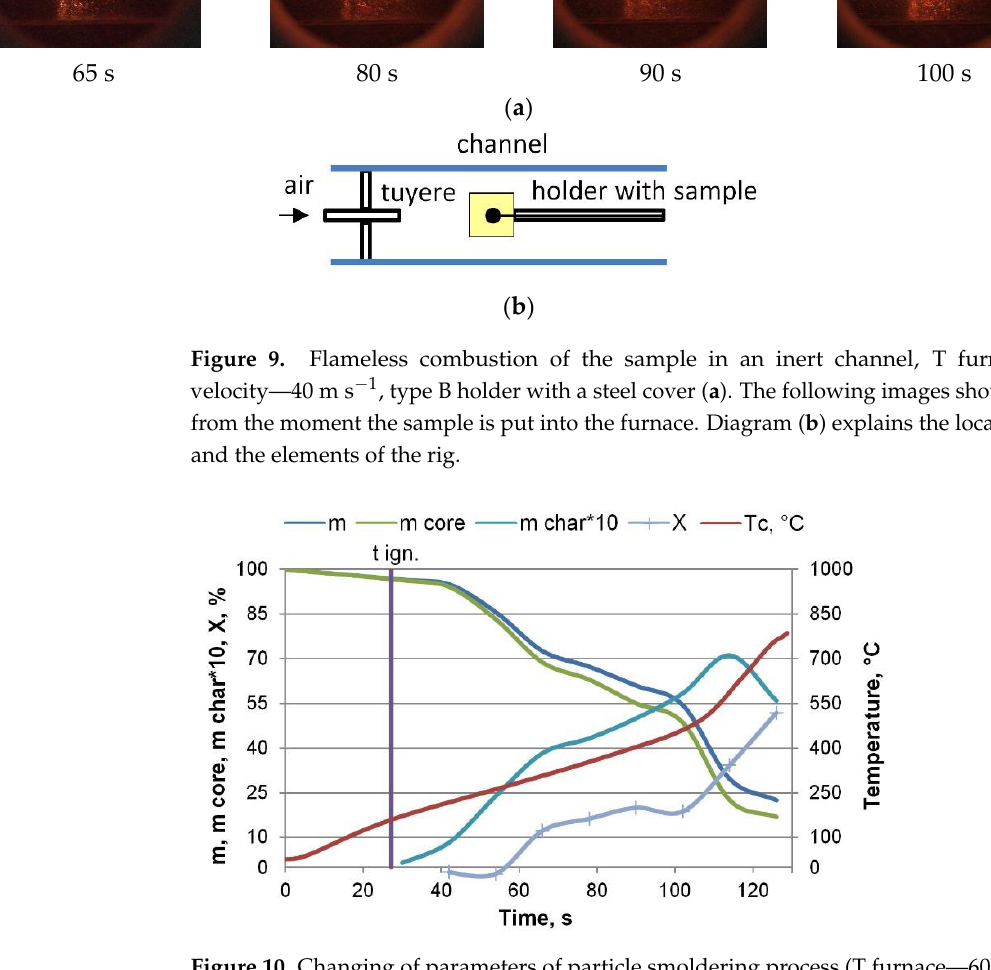
Figure 10. Changing of parameters of particle smoldering process (T furnace—600 °C, air velocity—40 m s −1 , combustion in the channel): m —relative mass of the charred particle, m core —mass of particle wood core, m char —mass of char layer, X —degree of overlapping of stages; t ign. —average time of particle smoldering start, s; T c —temperature of sample center, °C.